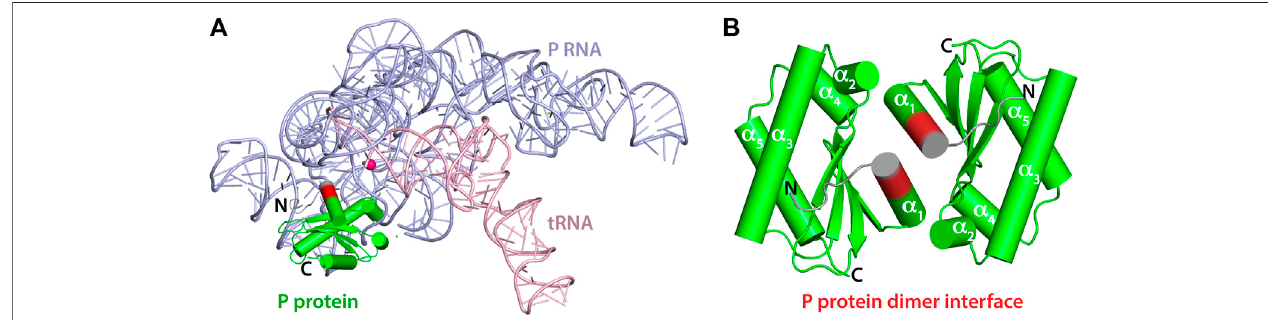
FIGURE 1 | Crystal structures of T. maritima RNase P components. (A) Crystal structure of the holoenzyme in complex with tRNA (PDB 3Q1Q). RNase P RNA componentisshowninlightblue,thePproteincomponentingreen,andtRNAinlightpink.Theenzymeactivesiteisdenotedbythelocationofacatalyticmagnesiumion (magenta sphere). RNAs are represented as loops (backbones) and sticks (nucleobases) and the P protein is represented as cylinders ( α -helix) and arrows ( β -sheets). Protein residues 14 – 17 are highlighted in red to indicate the location of the dimerization interface of the P protein alone (PDB 1NZ0). Residues 8 – 21 play a critical roleinbindingthePRNAaspartoftheholoenzymecomplexandinoptimallyaligningthe5 ’ leaderptRNAsubstrate. (B) 1.2 ÅresolutioncrystalstructureofthePprotein shown as a dimer, with molecules A and C (PDB 1NZ0). Protein residues 14 – 17 are highlighted in red and the N-termini in colored grey. Residues 1 – 15 are oriented differently between A and B .